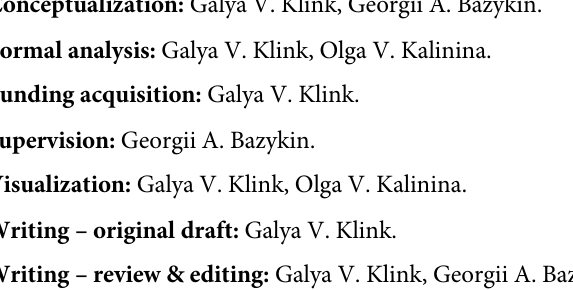
S1 Table. Differences in fitness constraints between subtypes A, B and C of HIV-1.